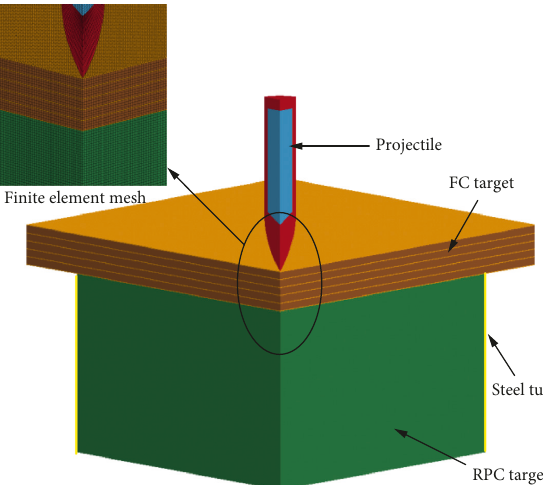
Figure 6: Numerical model of the target.